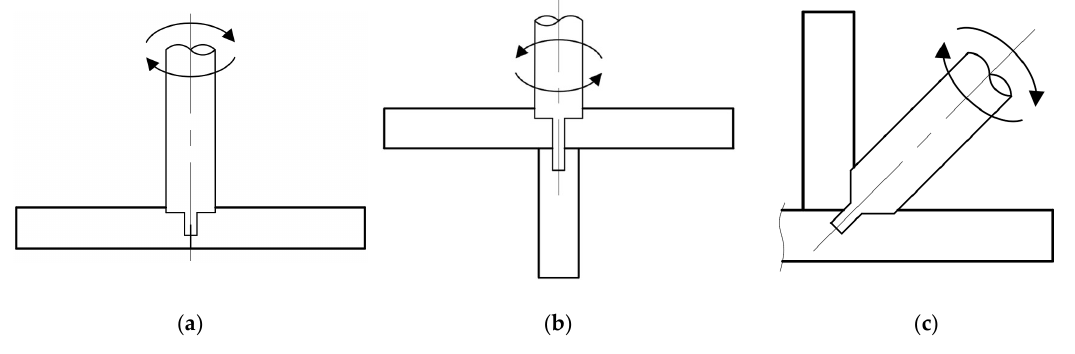
Figure 2. Types of FSW joint: ( a ) Butt FSW; ( b ) T-joint FSW; ( c ) fillet joint FSW.